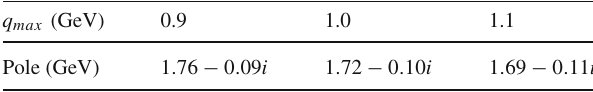
Table 3 The resonance pole for different cutoffs